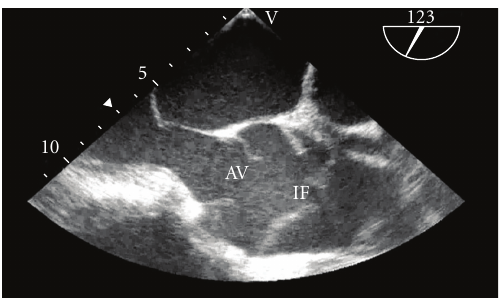
Figure 2: TEE image of the aortic valve (AV) and root in mid- esophageal long axis view. The dissection is visible just distal to the sinotubular junction. Notice that the intimal flap (IF) traverses the width of the proximal